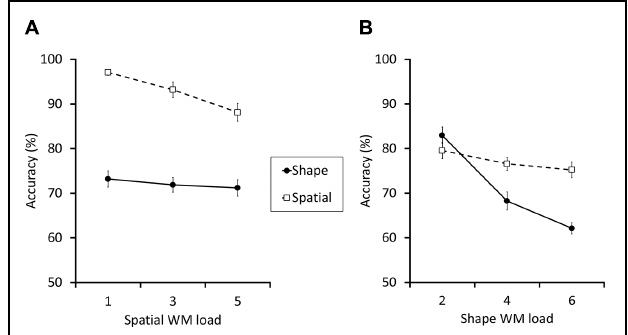
FIGURE 4 | The results for Experiments 2 (A) and 3 (B). The broken lines with empty squares and the solid lines with filled circles indicate the accuracy (% correct) of the spatial and the shape WM test trials, respectively. In Experiment 2, although the spatial WM accuracy apparently diminished along with the increment of load size, the shape WM did not. In contrast, the results of Experiment 3 indicated that the shape WM performance sharply fell as the load size increased, whereas the spatial WM did not. The error bars indicate the